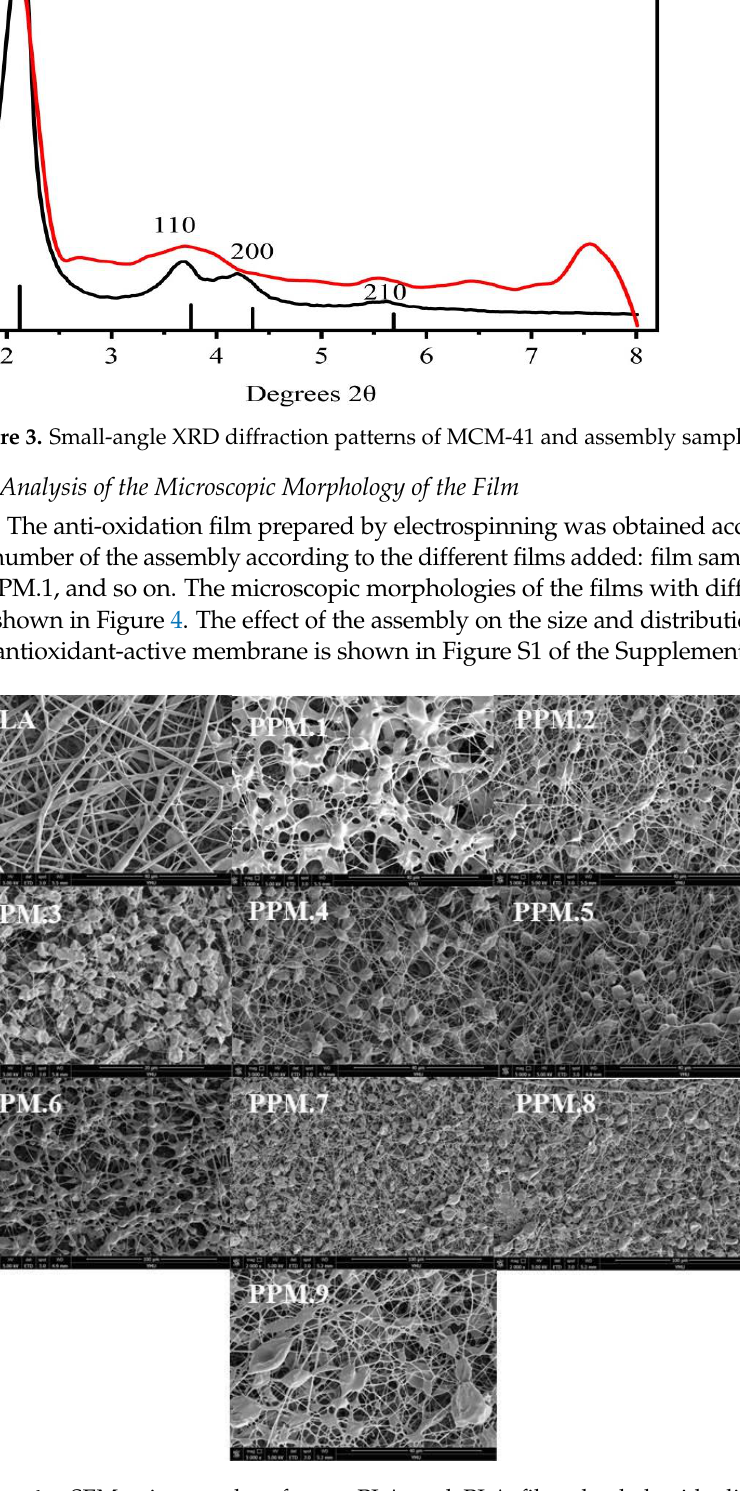
Figure 4. SEM micrographs of pure PLA and PLA films loaded with different amounts of phlo- ridzin/MCM-41 assembly. phloridzin/MCM-41